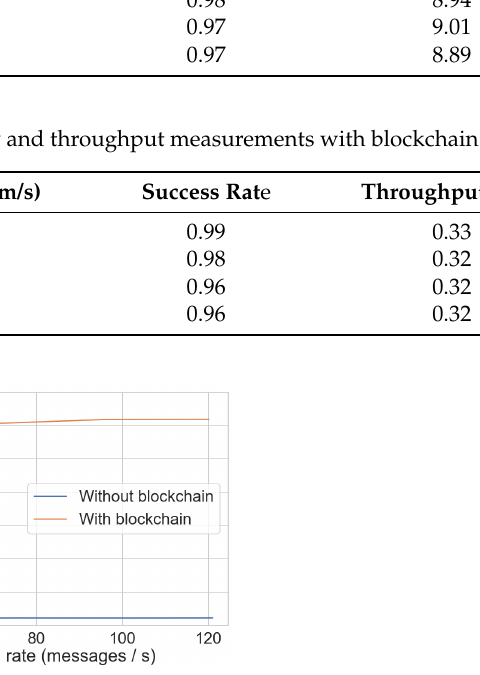
Figure 7. Latency comparison depending on the send rate.